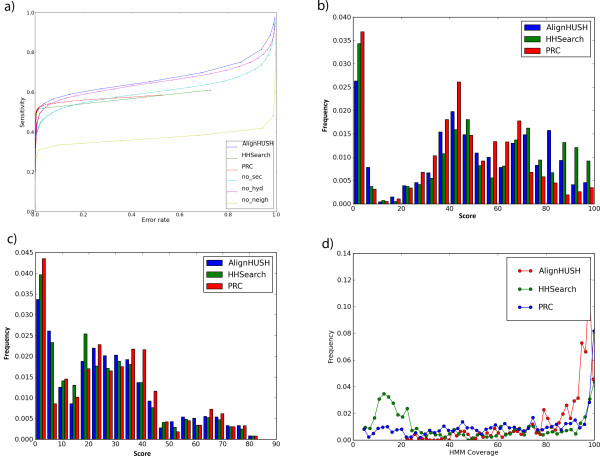
Comparison of performance of AlignHUSH method to HHSearch and PRC. A) The sensitivity and error rate values for both AlignHUSH and HHSearch are plotted in this figure. The sensitivity of AlignHUSH is better than HHSearch or PRC at almost all error rates. The 'no_sec', 'no_hyd' and 'no_neigh' are variants of AlignHUSH procedure without use of secondary structure, hydrophobic and neighboring column information respectively. B) Alignment accuracy of the three methods that have been examined in detail in the main text. The alignment accuracy given in this plot corresponds to the 'developer score' defined in the main text. The three methods are comparable as far as the accuracy using developer score is concerned. C) The alignment accuracy of the three methods using the 'modeller score' defined in the main text. The performance of AlignHUSH is slightly better than that of HHSearch and PRC. HHSearch generated alignments tend to be very short and hence HHSearch has a low value for 'modeller score' alignment accuracy. D) The length of the query HMM covered by the alignment is plotted for the alignment between homologous families (two SCOP families belonging to the same SCOP superfamily). The coverage of query HMM is greater in case of AlignHUSH than HHSearch which indicates that AlignHUSH generated alignments are more informative for function annotation, since they cover almost the entire homologous region. The alignment length coverage is very similar between the PRC generated alignments and AlignHUSH generated alignments.